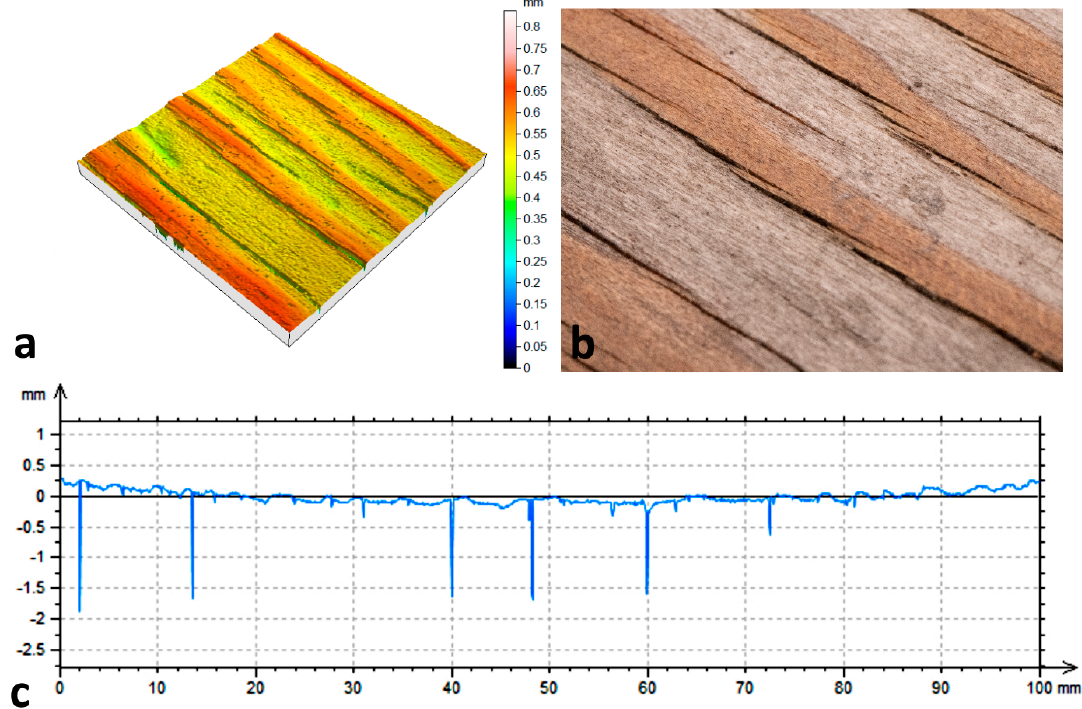
Figure 4. Appearance of a western larch deckboard with growth rings oriented bark-side-up and exposed to the weather for 7 months in Vancouver, Canada: ( a ) confocal profilometry height map showing surface checking and roughening of the wood surface; ( b ) photograph matching the image in Figure 4a; and, ( c ) confocal profilometry line scan showing variation in height of images in Figure 4a,b.